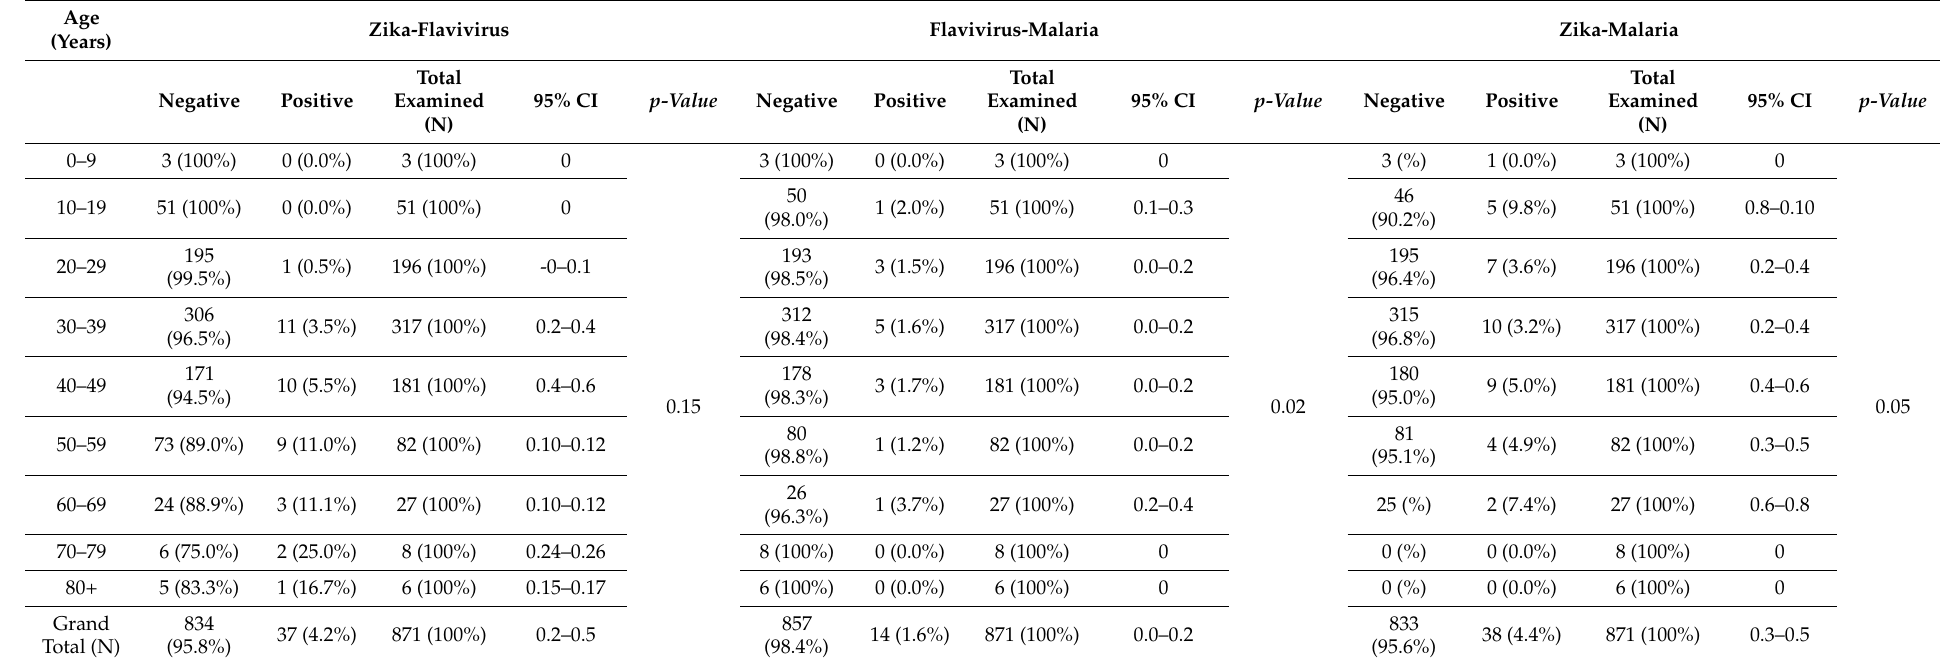
Table 5. Age-specific seropositivity of Zika, malaria, and